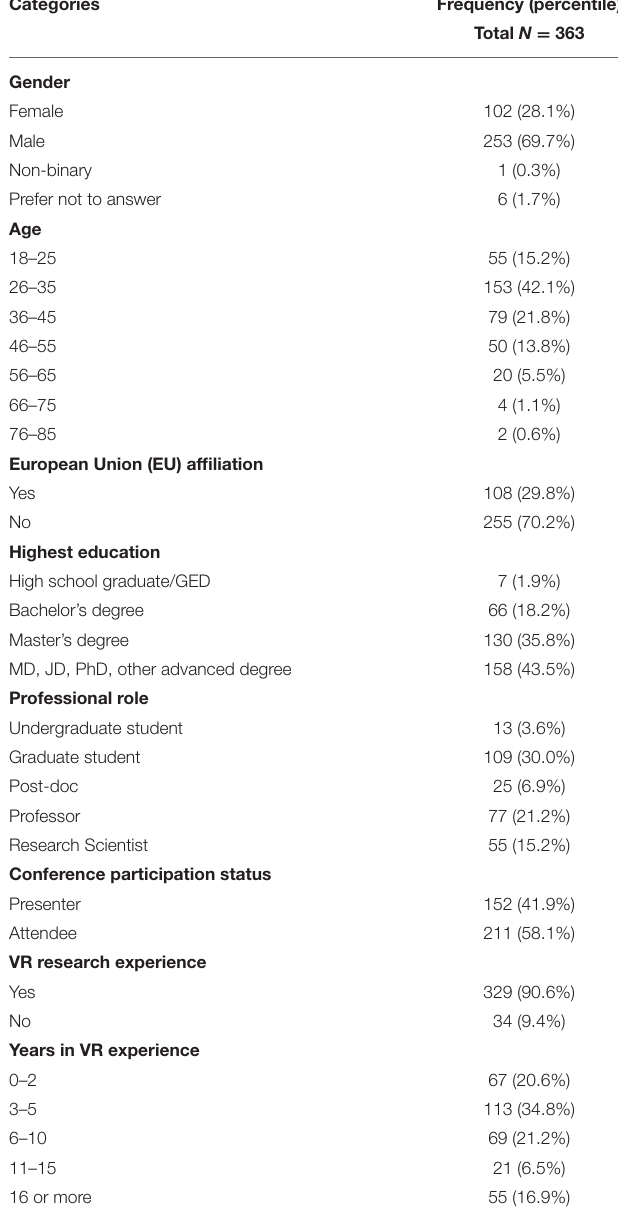
TABLE 1 | Demographic information of survey respondents.